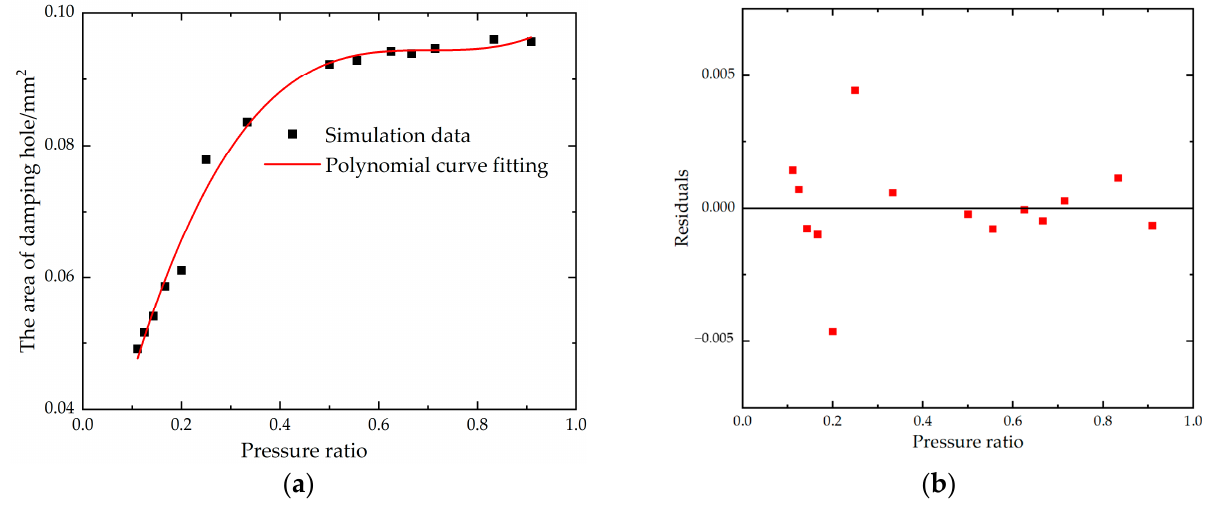
Figure 7. The variation law of equivalent damping hole area with pressure ratio: ( a ) Fitting curves under different pressure ratios; ( b ) Residual diagram at different pressure ratios.